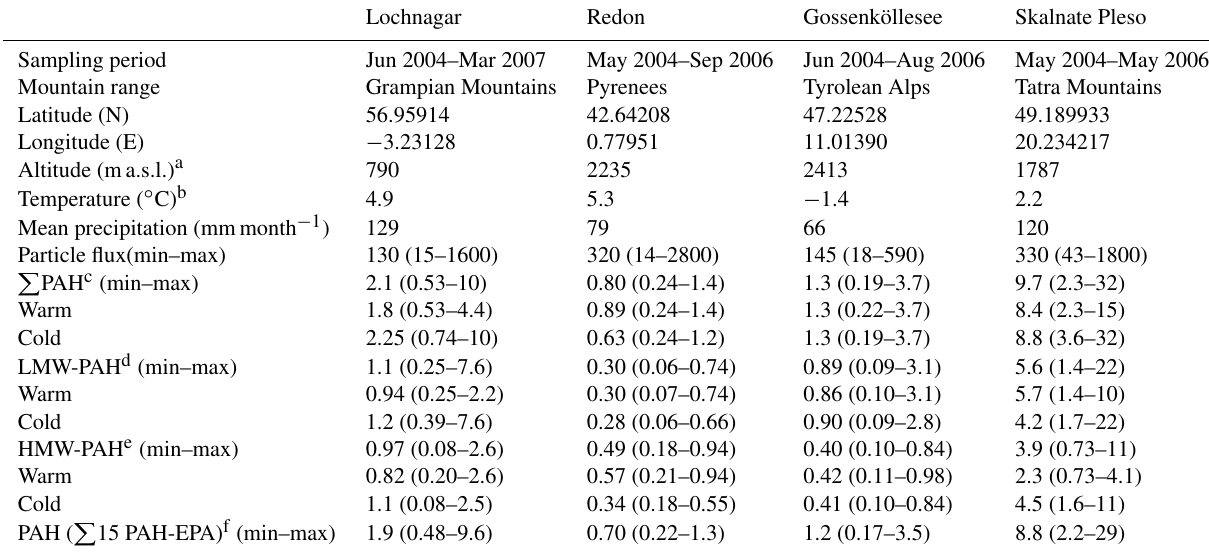
Table 1. Average temperature, atmospheric precipitation and particle (mgm − 2 month − 1 ) and PAH (µgm − 2 month − 1 ) monthly deposition fluxes in the European mountain areas considered in the present